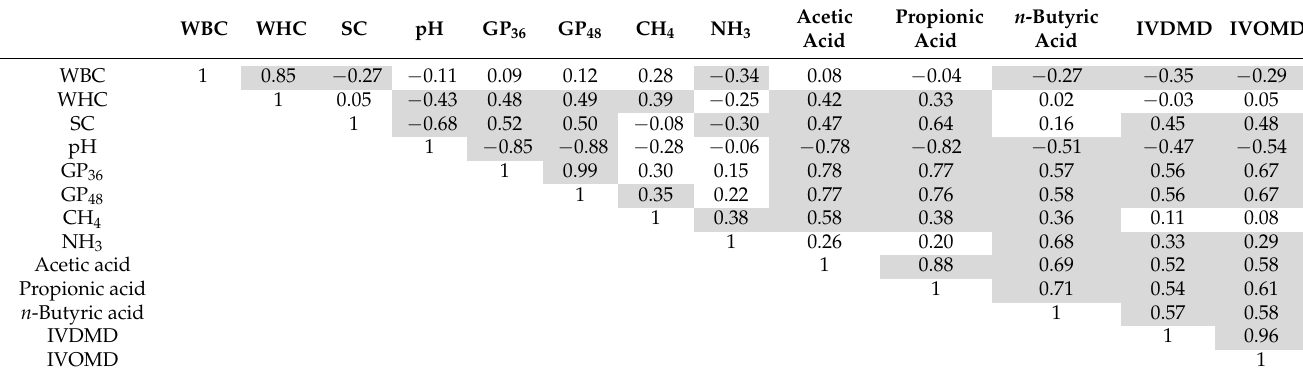
GP 36 : gas production measured after 36 h of incubation; GP 48 : gas production measured after 48 h of incubation; IVDMD: in vitro dry matter digestibility; IVOMD: in vitro organic matter digestibility; SC: swelling capacity; WBC: water binding capacity; WHC: water holding capacity. Significant correlations are highlighted ( p <